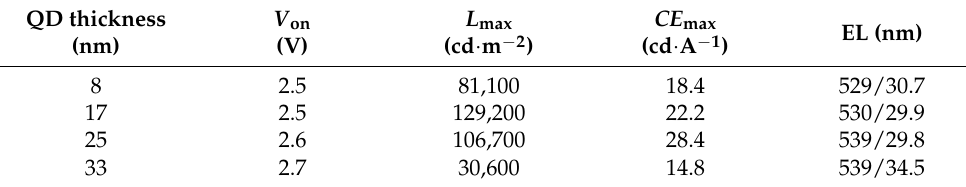
Table 3. Performance summary for the TEQLEDs with various QD thickness and 30 nm ZnO.